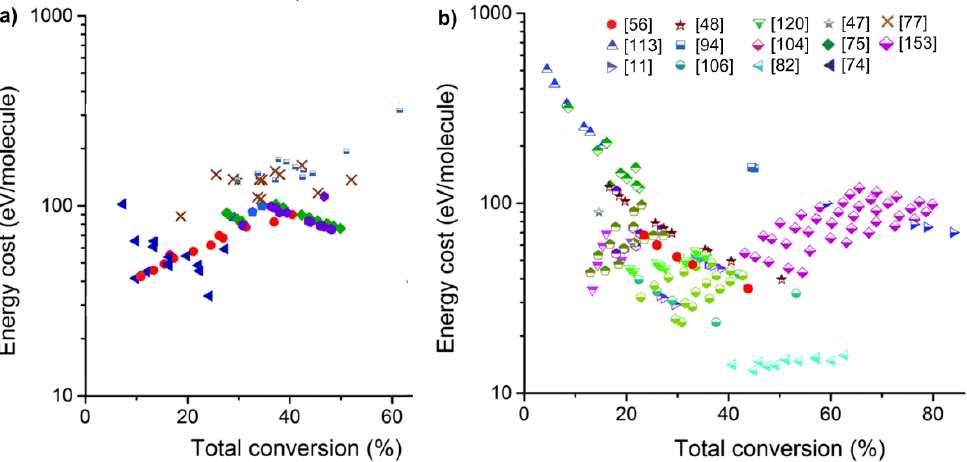
Figure 3. Experimental data collected from literature for direct reforming of methane with carbon dioxide for ( a ) non packed dielectric barrier discharge ( b ) packed bed dielectric discharge barrier. Reproduced with permission from [62]. Copyright 2020, RSC.